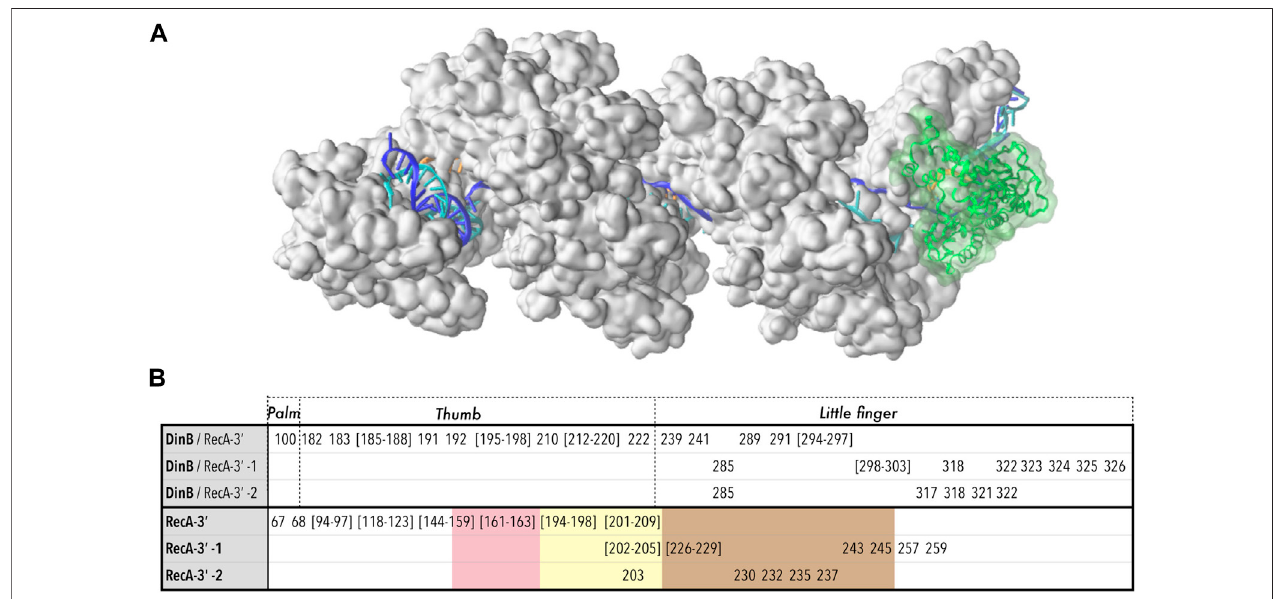
FIGURE 6 | Model structure of the RecA*-DinB complex, after 270 ns molecular dynamics simulation. (A) The protein part of the RecA* fi lament (close to three fi lament turns) is formed by 17 RecA proteins shown in surface representation, in white. The fi lament binds three DNA strands (cartoon representation) organized as a D-loop: the ssDNA bound to the fi lament in site I, or primer (orange) binds the complementary or template strand (blue) in the region where that strand is incorporated in the fi lament, forming astretched/unwound heteroduplex; beyond the initial dsDNA entrypoint inthe fi lament in 5 ′ and its exit point in3 ′ , thecomplementary strand remainspairedwithitsinitialpartnerorleadingstrand(cyan)inarelaxedB-form.Thejunctionsbetweenthestretchedandrelaxedregionsformkinks.TheDinBproteinis represented in cartoon and transparent surface, in green. (B) Residues involved in the interface between DinB and the last three RecA monomers starting from the 3 ′ extremity (RecA-3 ′ , RecA-3 ′ -1, RecA-3 ′ -2). For DinB, correspondence with the “ Palm ” , “ Thumb ” and “ Little fi nger ” domains is reported; for RecA, the residues belonging to loops L1 (pink), L2 (yellow) or the LexA binding loop (marron), are indicated using color code shading. The same color code is used in Figure 5